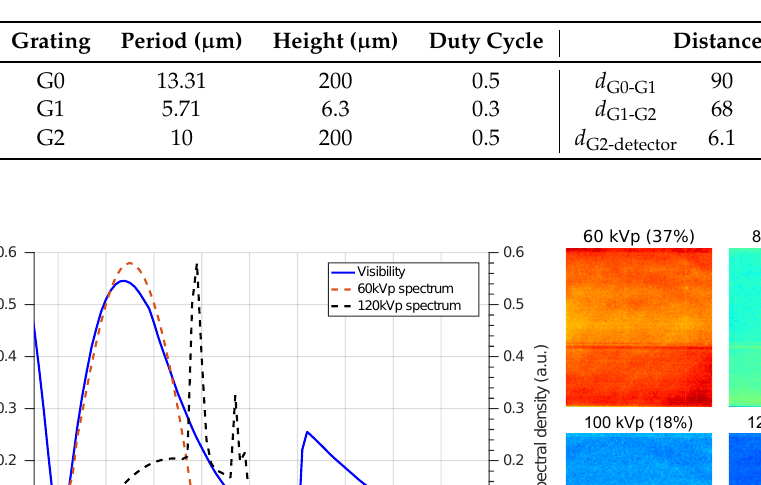
Table 1. Parameters of the used gratings (left) and distances (right). In this configuration a magnification factor of 1.87 is obtained.